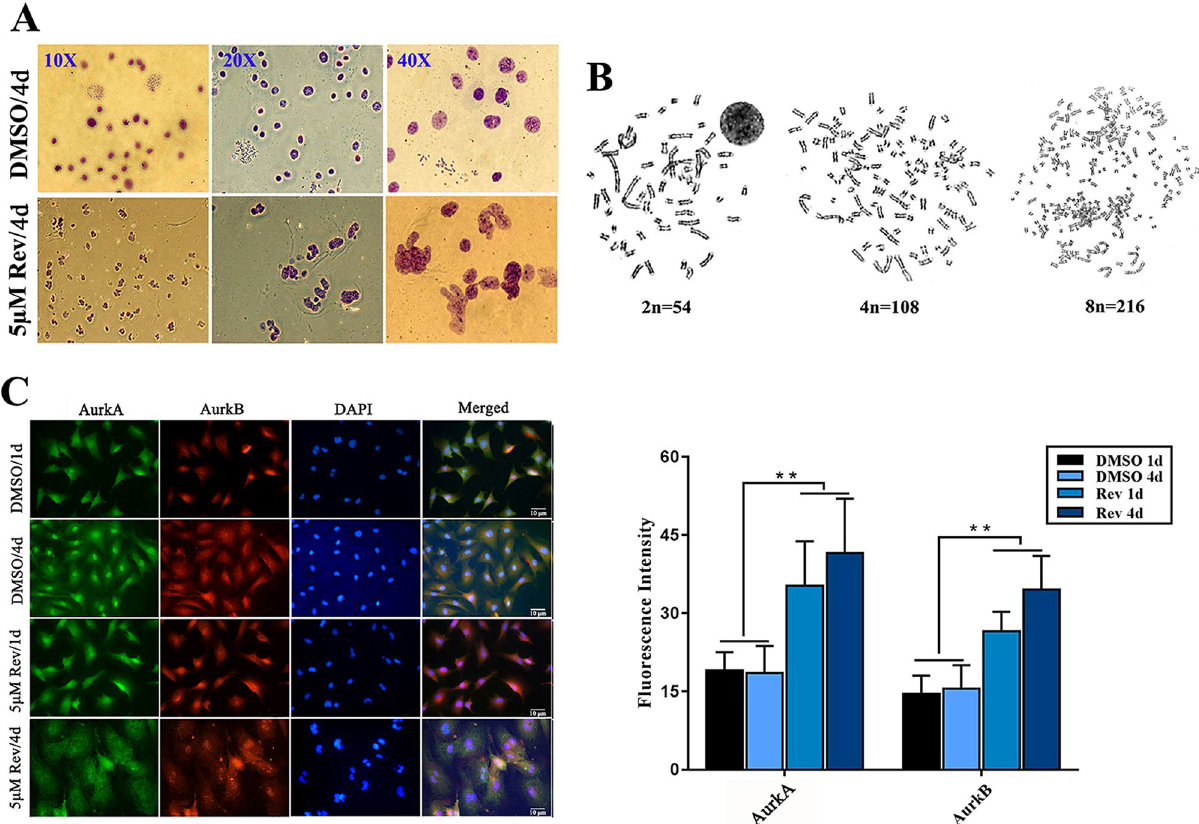
Figure 3. Reversine treatment significantly increases the number of cells over tetraploid. ( A ) Multinucleated cells were detected using chromosome Gimea staining. ( B ) Chromosome G-banding analysis verified the conversion of reversine-treated cells from diploid/mononuclear (2 N = 54) to tetraploid/binuclear (4 N = 108) and octaploid (8 N = 216). ( C ) The expression of Aurora A and Aurora B gradually increased with reversine treatment for 4 days by